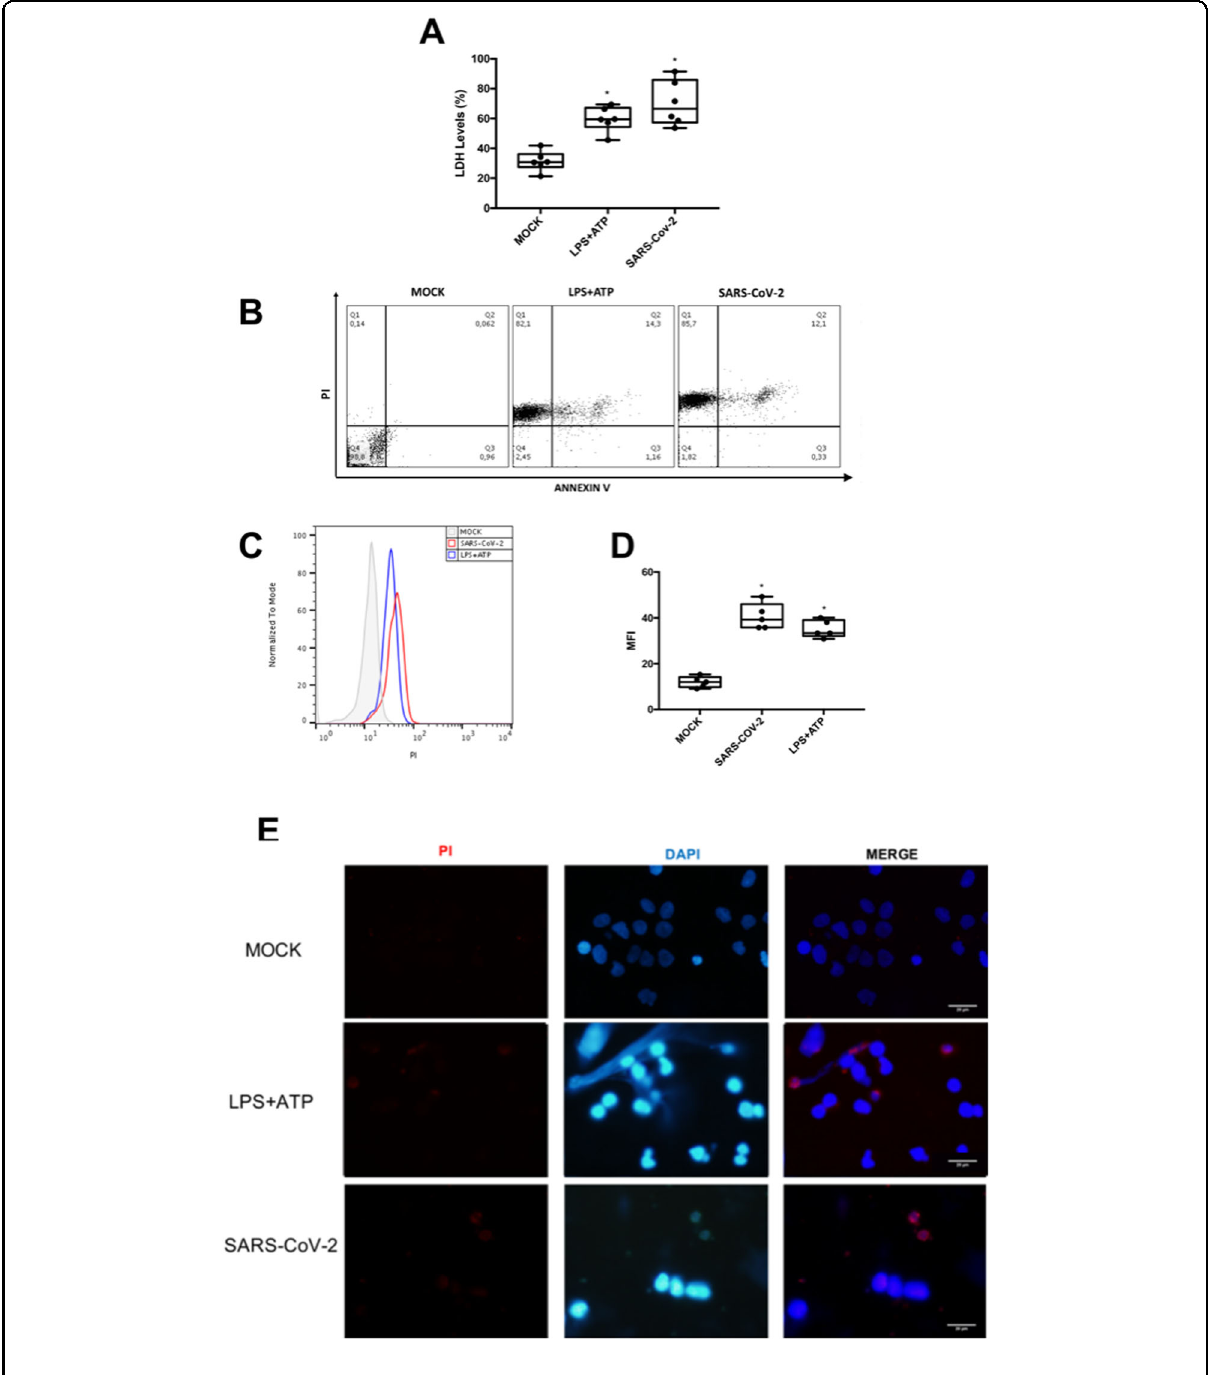
Fig. 1 SARS-CoV-2 induces lytic monocyte cell death. Human monocytes were infected with SARS-CoV-2 (MOI 0.1) for 24 h. As a positive control, monocytes were stimulated with LPS (500 ng/mL) for 23 h and, after this time, incubated with ATP (2 mM) for 1 h. A Cell viability was assessed through the measurement of LDH levels in the culture supernatant. B – D Monocytes were stained with propidium iodide (PI) and Annexin V. E Monocytes were stained with PI and DAPI, scale bar 20 μ m. Images and graph data are representative of six independent experiments. Data are presented as the mean ± SEM * P < 0.05 versus control group